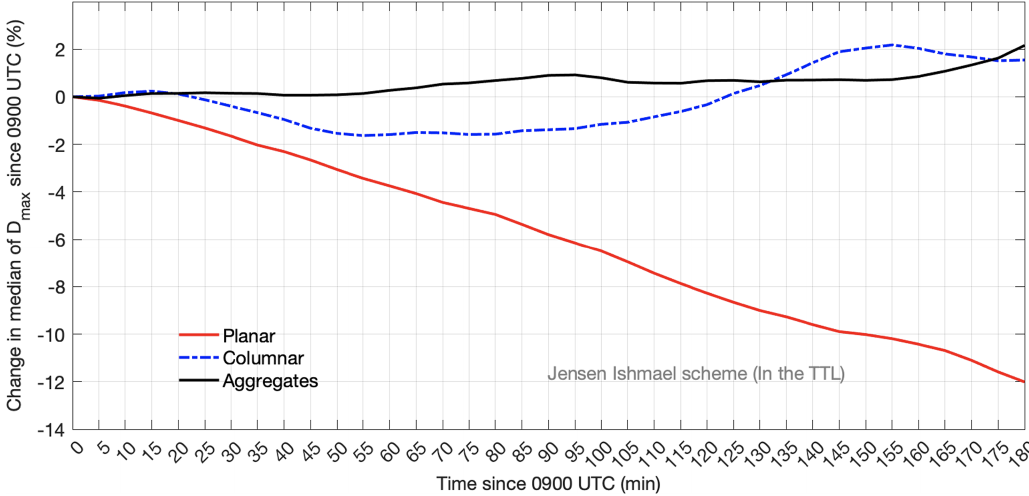
Figure 15. Time series (starting from 10 August 2017 at 09:00UTC) of the change in median value of simulated maximum dimension in the TTL using the ISHMAEL scheme for ice habits: planar (red), columnar (dashed–dotted blue), and aggregate